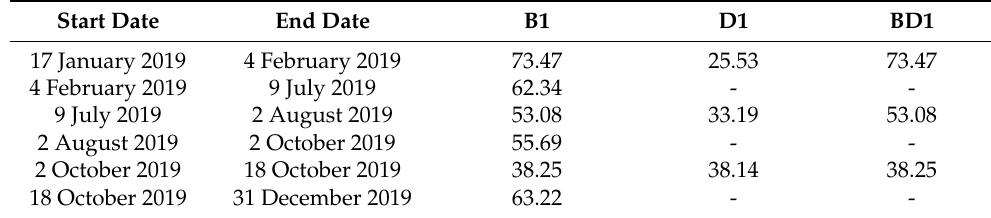
Table 2. NO 2 Annualized